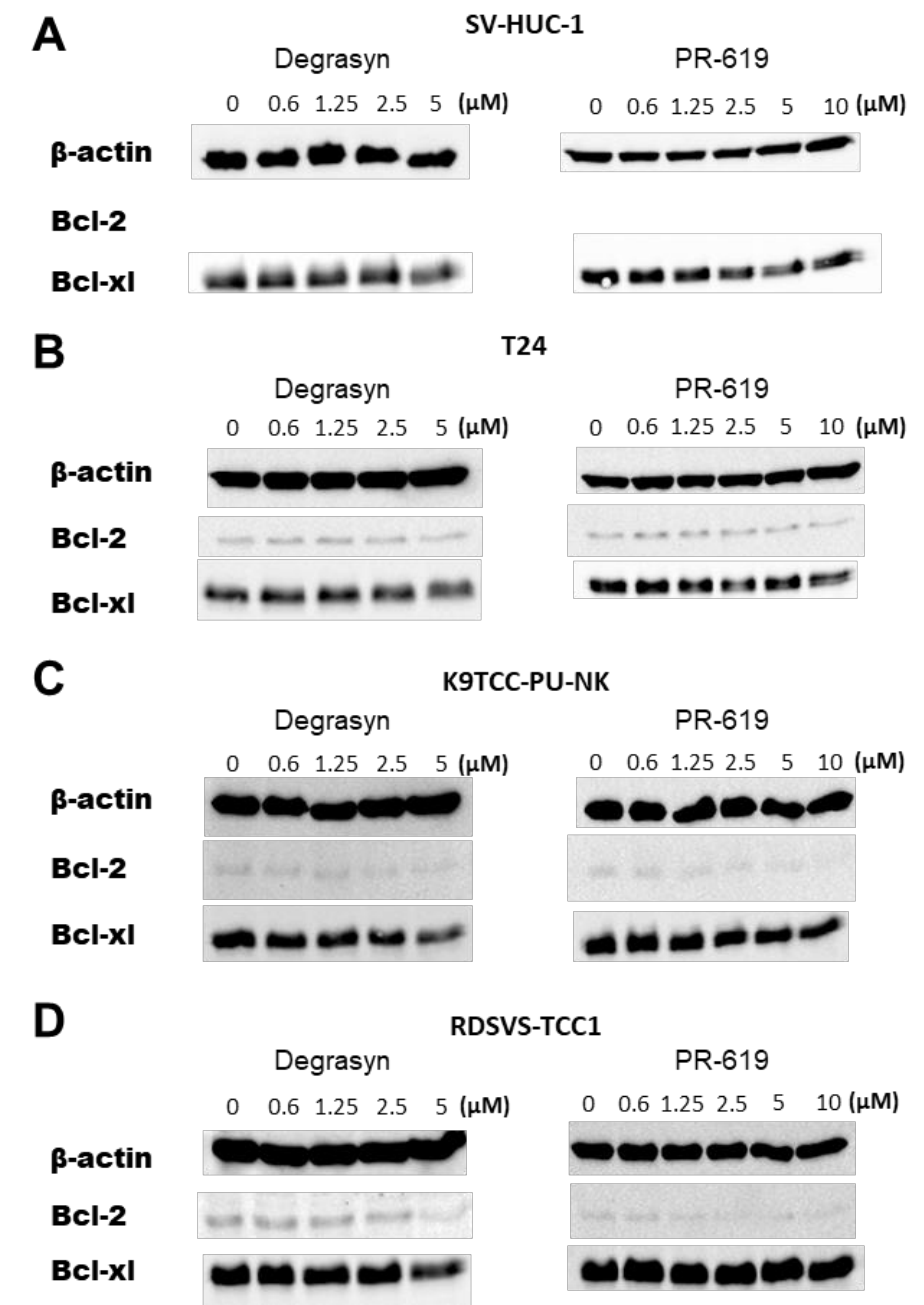
Figure 11 . Evaluation of proteins involved in apoptosis induced by Degrasyn and PR-619. Repre- sentative blot of Bcl-2 and Bcl-xl expression in ( A ) SV-HUC-1, ( B ) T24, ( C ) K9TCC-PU-NK, and ( D ) RDSVS-TCC cells after 24 h of treatment with increasing concentrations of Degrayn and PR-619. Actin serves as a loading control.